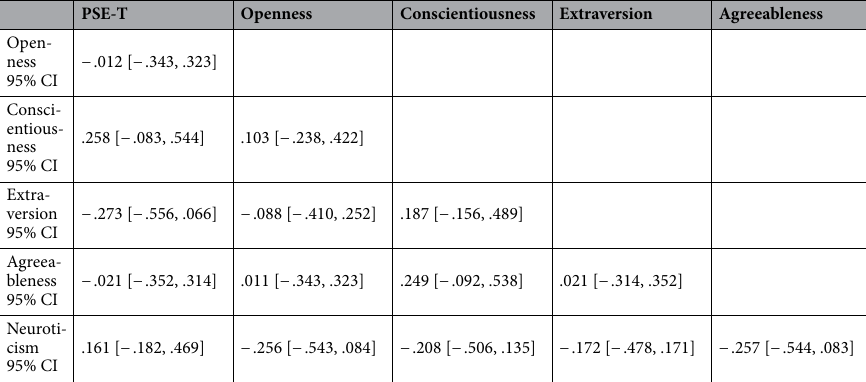
Table 2. Pearson correlation coefficients for PSE-T and personality factors, and among personality factors in Experiment 2. PSE-T is the quantity of rolls for which the participant considered the use of the tool and their hands as equivalent. 95% CI corresponds to the confidence interval. Significance levels are indicated as follows: * p < .05, ** p < .01, *** p <